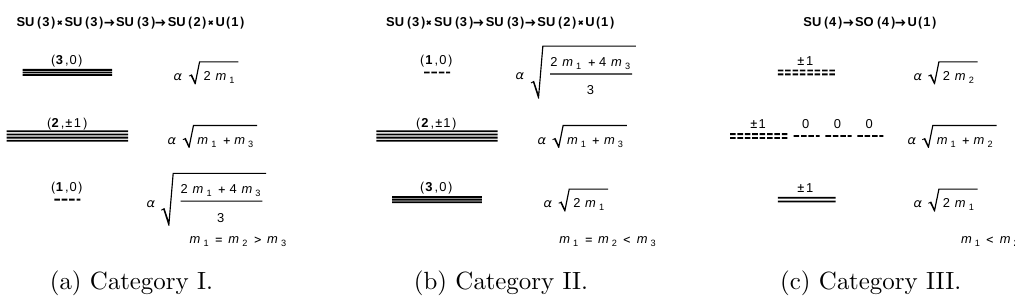
Figure 1. Examples of the three categories of symmetry breaking. Solid lines represent stable par- ticles and dashed lines unstable ones. Double/triple/quadruple lines represent particles degenerate in mass. The numbers above the lines are the quantum numbers of the pions under h . The masses of the pion multiplets (up to a global multiplicative constant) are shown on the